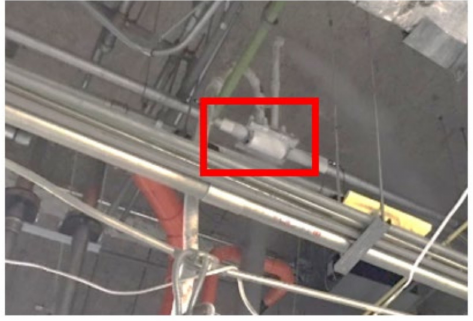
Figure 5. Horizontal pipe in a narrow space location.